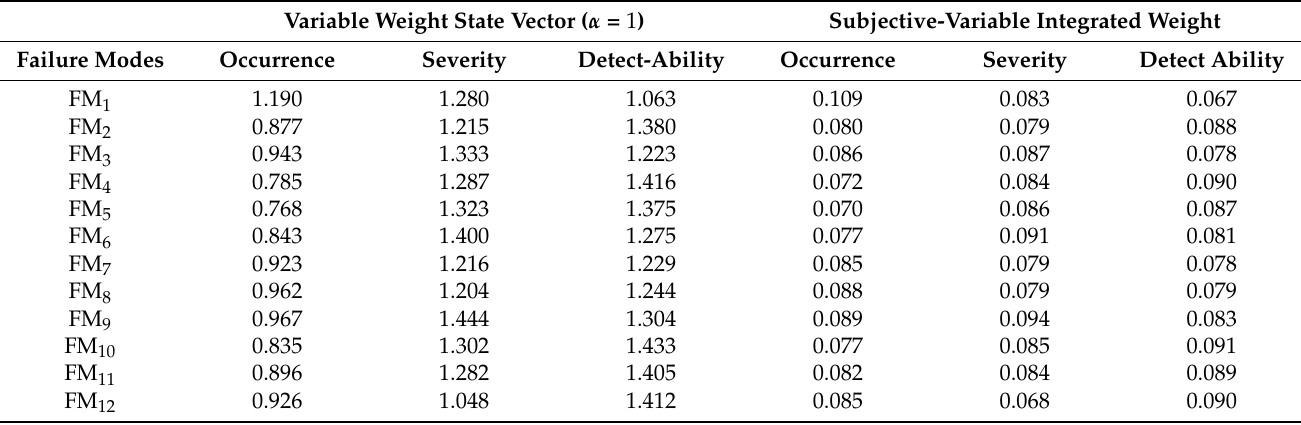
Table 8. Variable weight state vector and subjective-variable integrated weight for 12 failure modes. Variable Weight State Vector ( α = 1